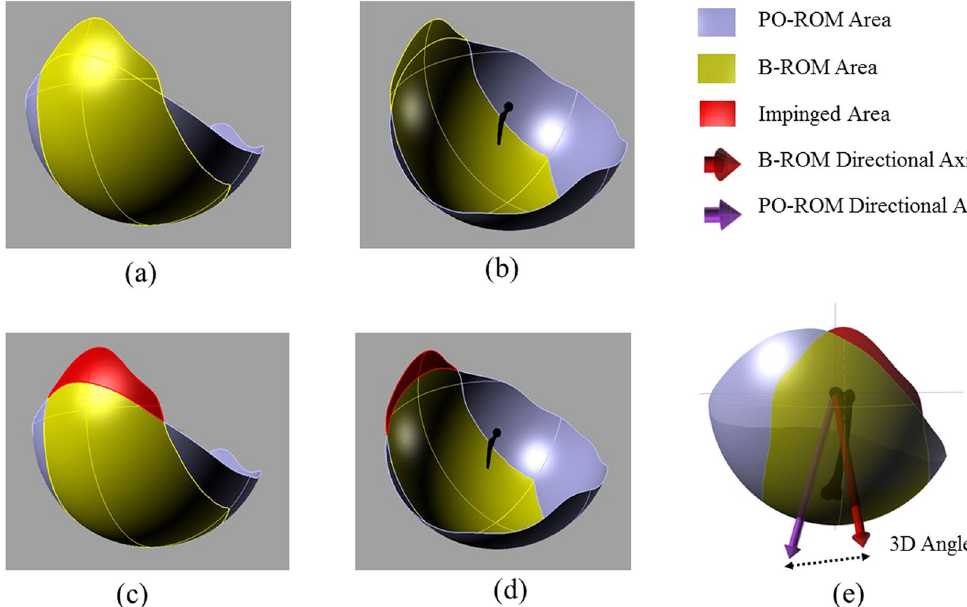
Figure 4. Schematic representation of PO-ROM area, B-ROM area, Impingement area, and 3D angle. ( a ) and ( b ) B-ROM overlaid PO-ROM; ( c ) and ( d ) Impingement area which is the part of BO-ROM area not covered by PO-ROM area; ( e ) Difference between BO-ROM directional axis and PO-ROM directional axis in terms of 3D angle.